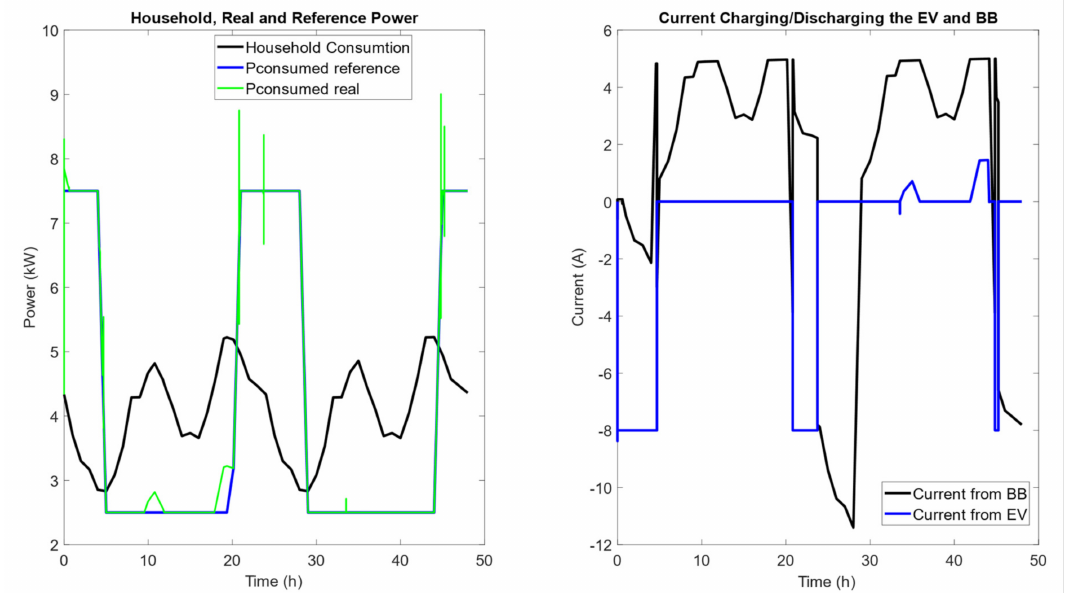
Figure 17. System simulation for 2 days ( left ) AC power reference and real consumption ( right ) battery currents waveforms. The system state for both converters and battery SOC for both the EV and battery bank are shown in Figure 18.